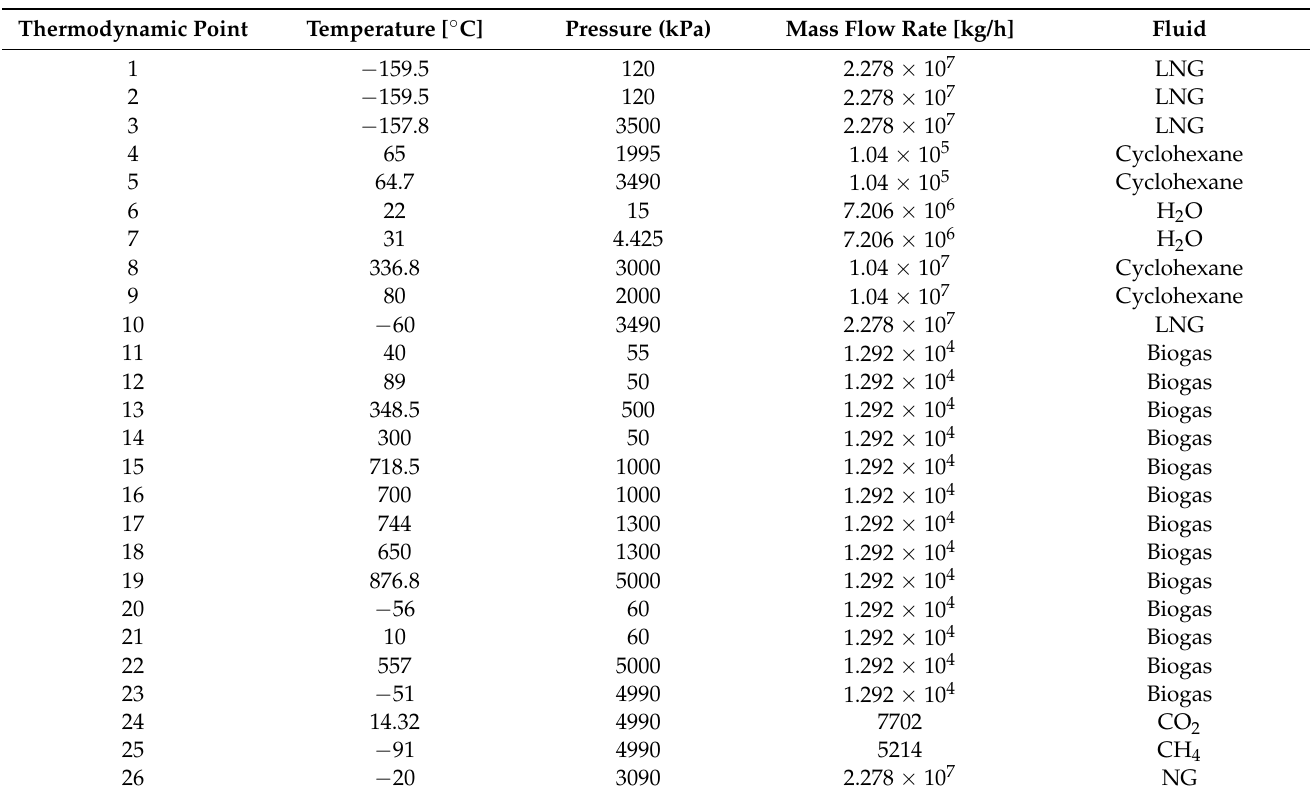
Table 4. Detail of Configuration I operating values using cyclohexane as the working fluid.